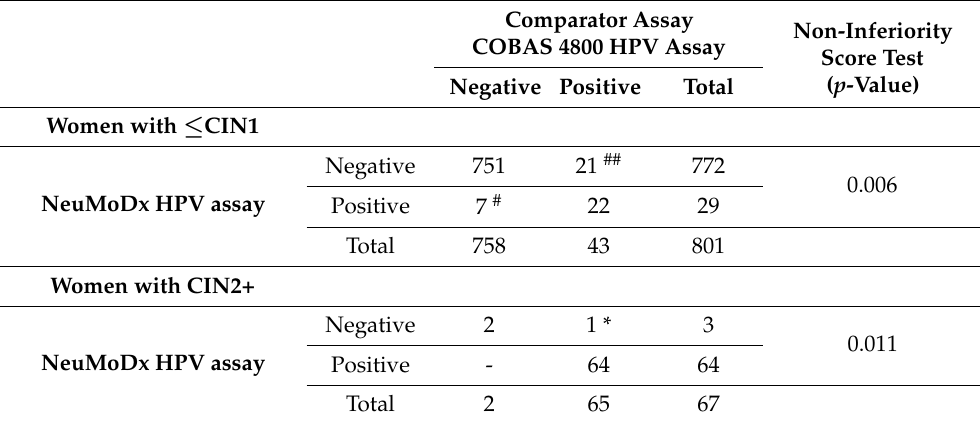
Table 6. Clinical performance for CIN2+ of NeuMoDx HPV assay on PreservCyt collection medium (group 1)—Comparator COBAS 4800 HPV assay.